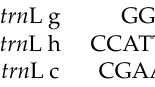
Table 1. Primer sequences used for Illumina sequencing ( trn L g-h) and for Sanger sequencing ( trn L c-h). trn L g GGGCAATCCTGAGCCAA trn L